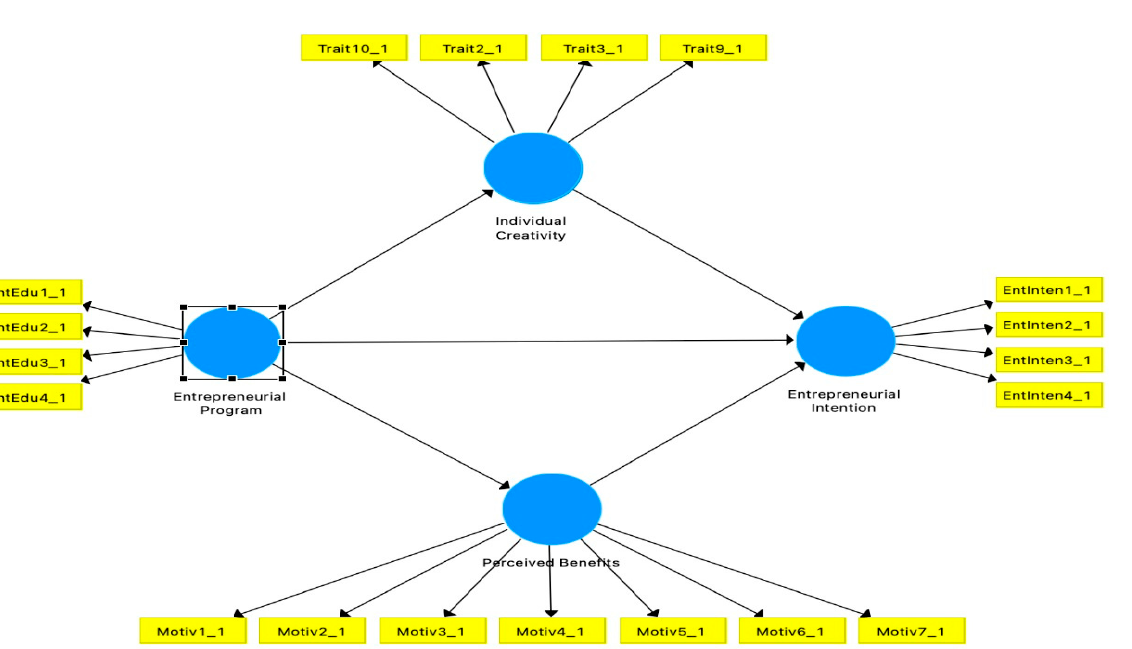
Figure 1. Research model and hypotheses.